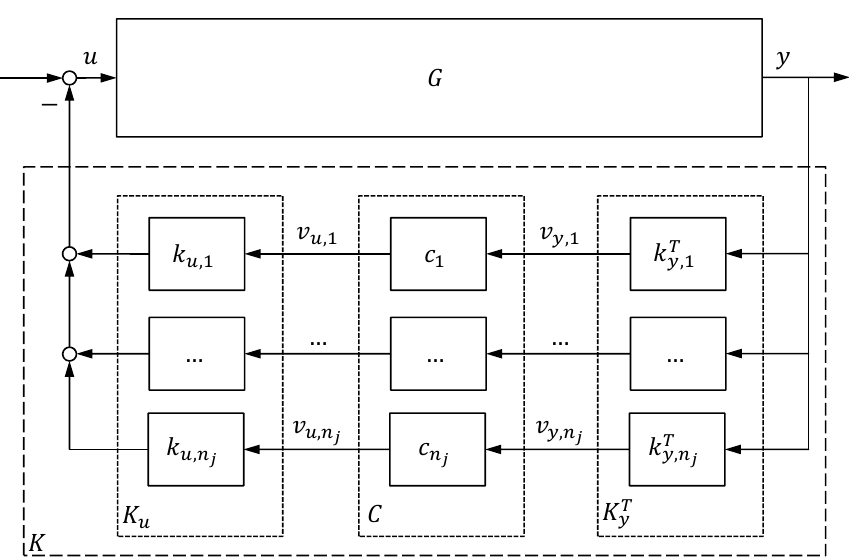
Figure 2. Closed-loop interconnection of plant G with flutter suppression controller K , output blending matrix K y , input blending matrix K u , and controller C